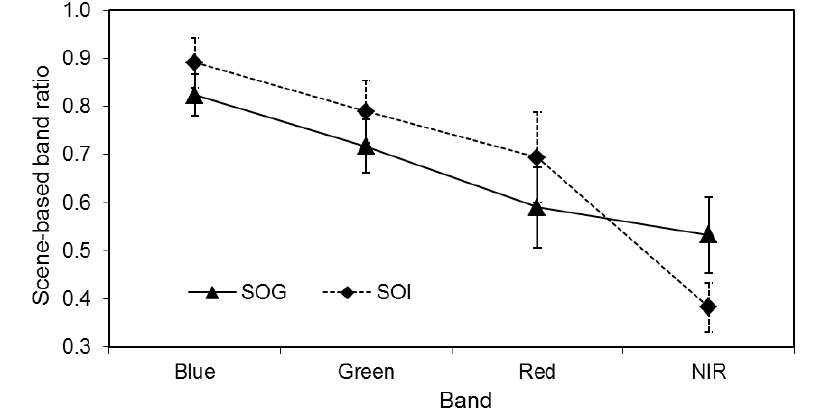
Figure 3. The spectroradiometric differences between shadows on grass (SOG) and shadows on impervious surfaces (SOI) shown in scene-based band ratios derived from the digital numbers of sampled shadow pixels ( n = 65). The vertical lines indicate the range of variability in the blue, green, red, and near infrared (NIR) bands of QuickBird